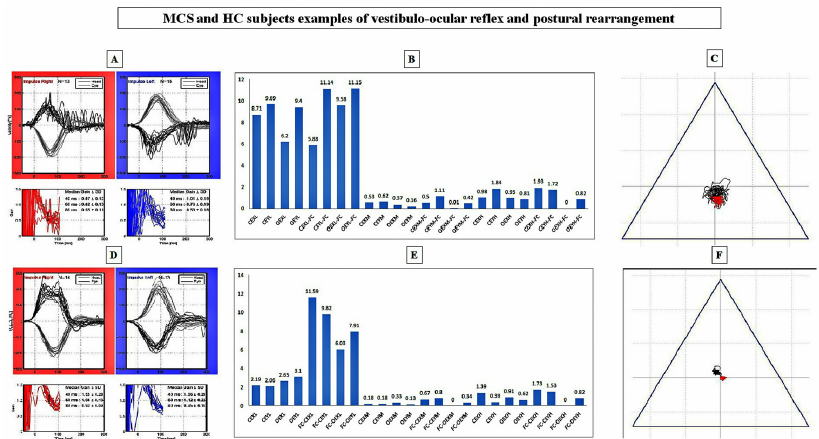
Figure 3. An example of a single MCS and HC subject respectively represented in ( A ) and ( D ) for video Head Impulse Test trace and results; in ( B ) and ( E ) for fast Fourier transform results; in ( C ) and ( F ) for X ‐ Y plane plot. CE, closed eyes; OE, open eyes; X, spectral values of body oscillations on X plane; Y, spectral values of body oscillations on Y plane; L, low frequency interval; M, middle frequency interval; H, high frequency interval; FC, foam carpet; MCS, multiple chemical sensitivity; HC, healthy subject.